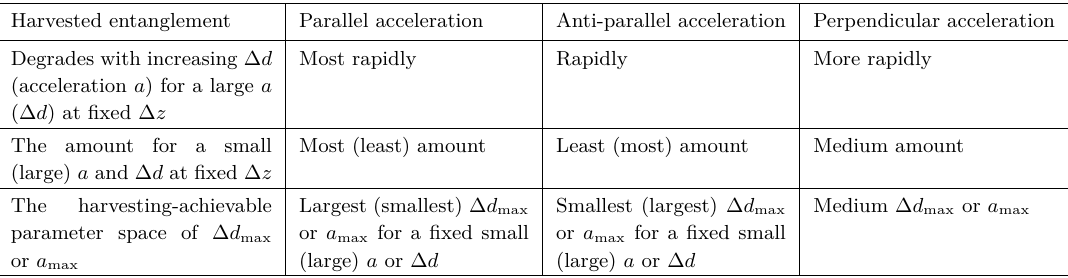
Table 2. Main results for three acceleration scenarios in